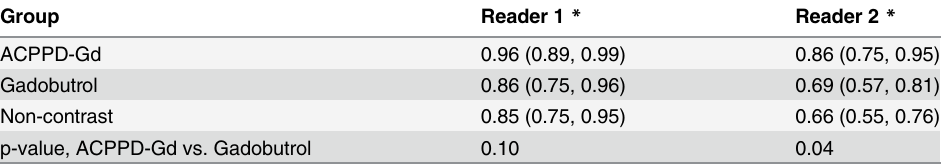
Table 3. AUCs (95%CIs) from ROC curves for classifying tumor presence status based on tumor pres- ence confidence scores given by group and reader for all tumors < 5mm 3 (n = 58). Group